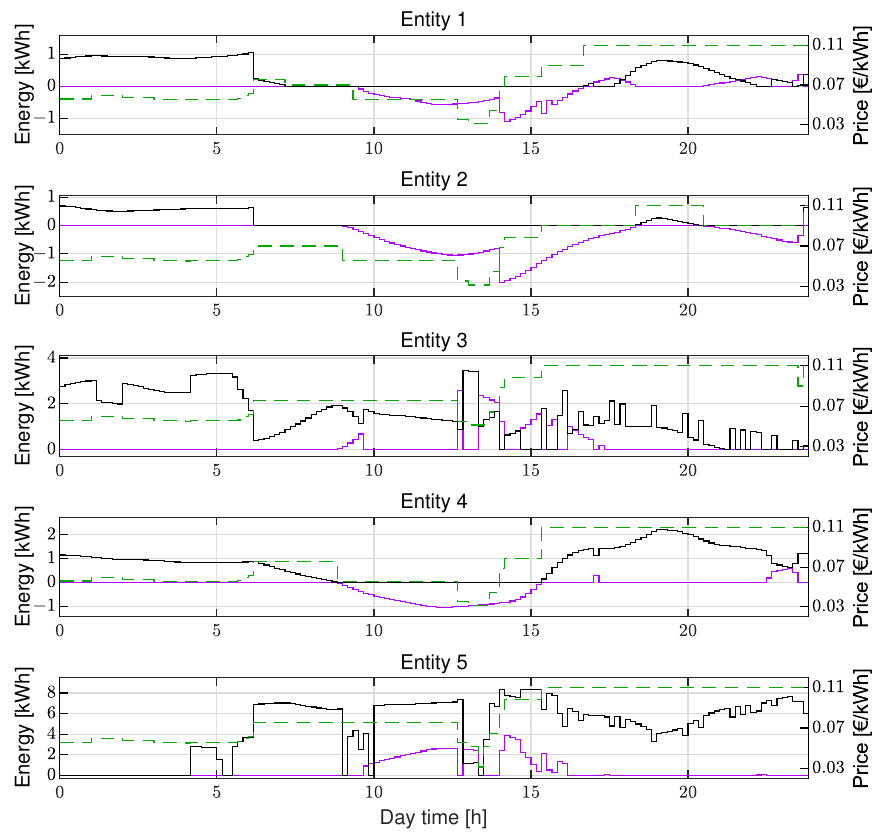
Figure 8. Example 3, proposed heuristic. Energy exchanged inside the community (purple), energy exchanged with the grid (black) and community prices (green) for all entities in day 10. Focusing on the entity hosting EVs, it would incur an average daily cost of 71.21 e by acting alone, while joining the community grants a cost reduction of 11.83%. To evaluate compared to that returned by the MILP. In the considered setup, the two approaches show similar results. In fact, the maximum daily gap between the two solutions is less than